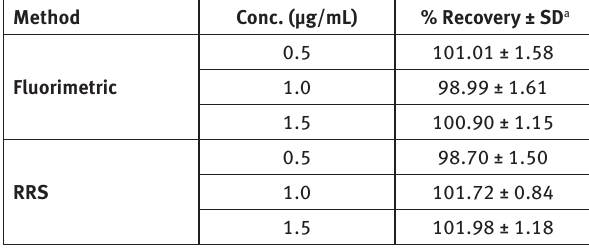
Table 2: valuation of accuracy for the suggested spectroscopic methods Method